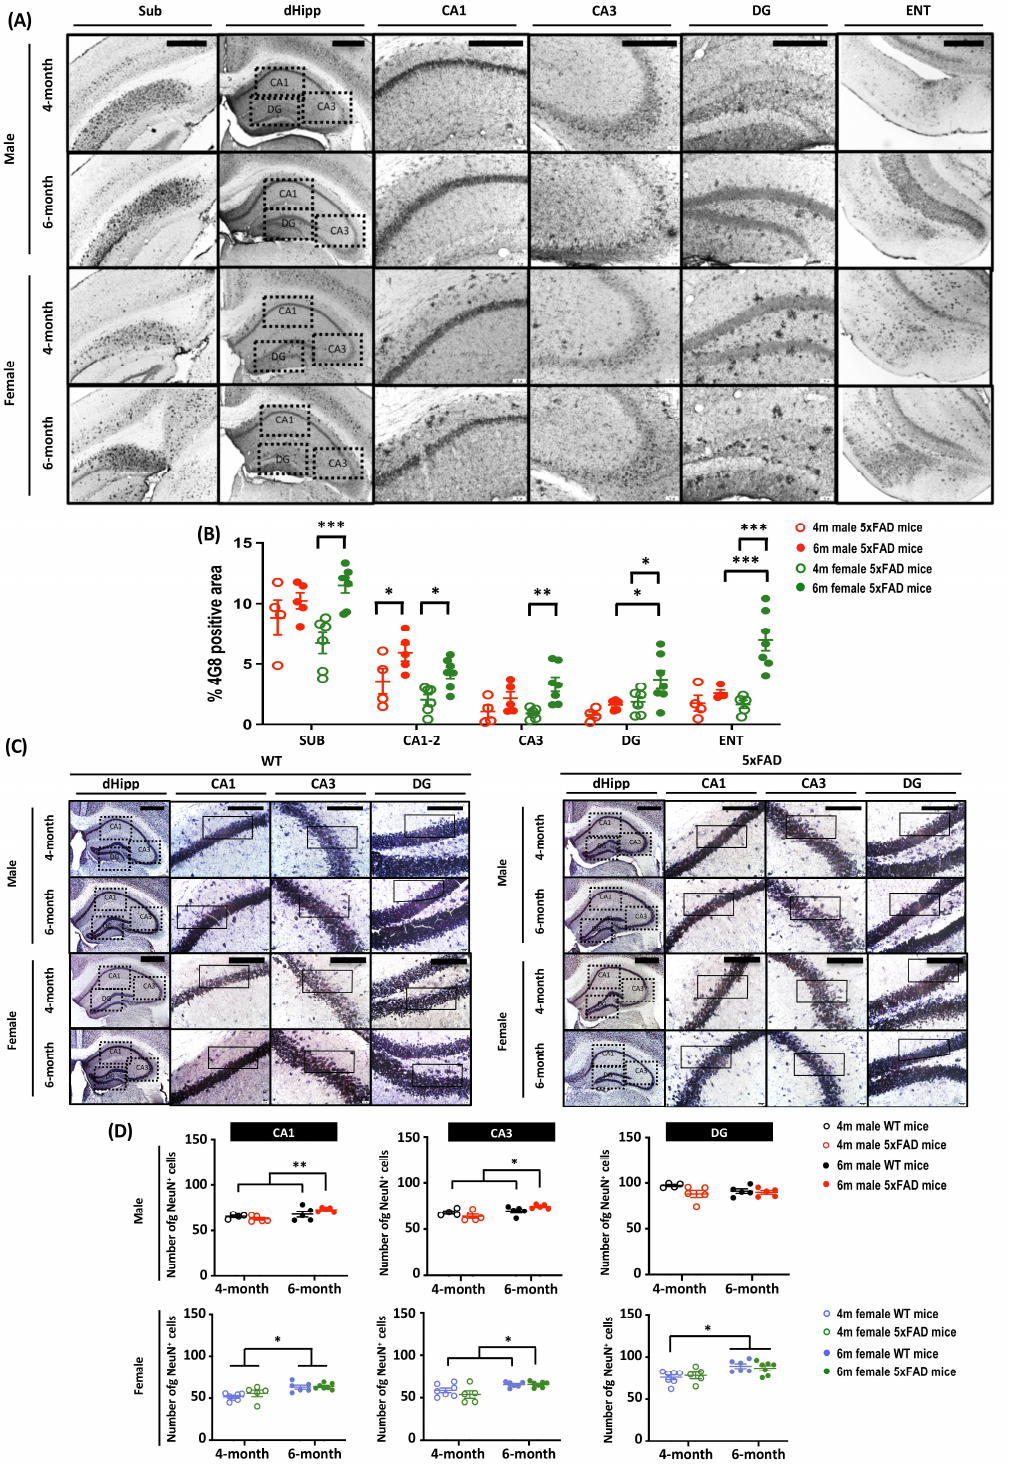
Figure 2. Amyloid burden and neuronal loss in brain regions related to memory in 4- and 6-month-old male and female 5xFAD mice. Diffused amyloid deposition was observed in brain regions